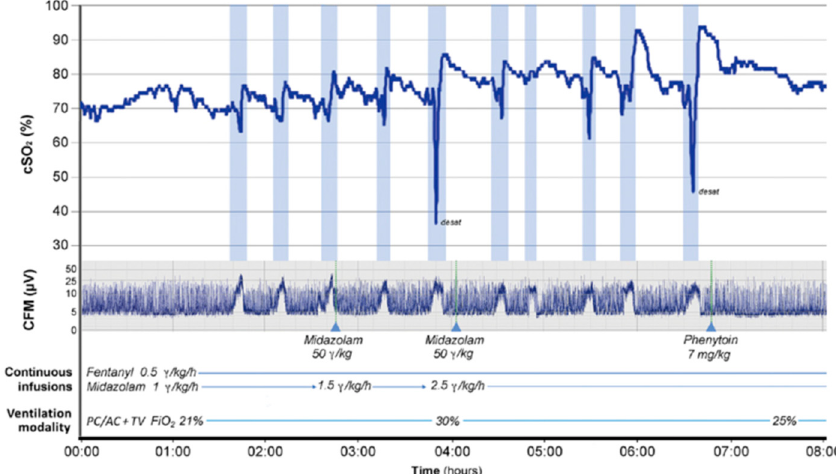
Figure 4. Changes in rSO 2 and electrical activity on cerebral function monitoring (CFM) trace during seizures (highlighted by blue bars). SIPPV + VG is the ventilatory mode, synchronized intermittent positive pressure ventilation with volume guarantee [75]. Copyright (2019) by (Georg Thieme Verlag KG Stuttgart). Reproduced with permission of (Georg Thieme Verlag KG Stuttgart) in the format of (Journal/Magazine/Newspaper) via Copyright Clearance Center. Permission remains with (Georg Thieme Verlag KG Stuttgart). Any reuse of this image must be requested from the publisher directly. Wallois et al. [82] commented on changes during the post-ictal period; rSO 2 remained low and gradually recovered with time, as observed in 13 out of the 20 reported